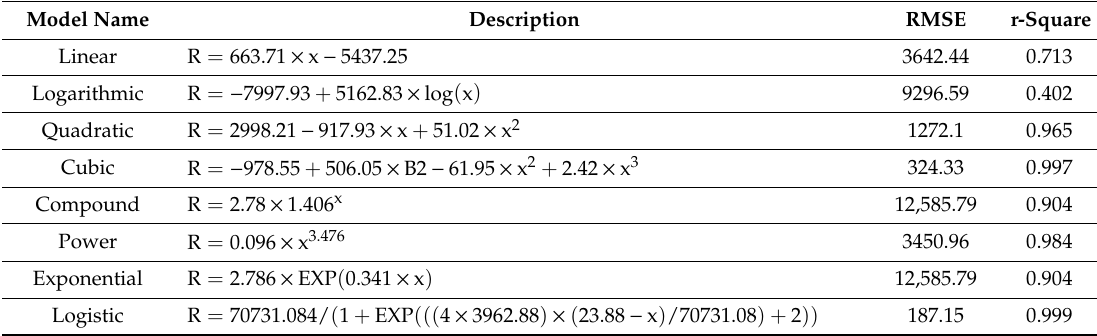
Table 12. Model description for Italy fitted by GWO.